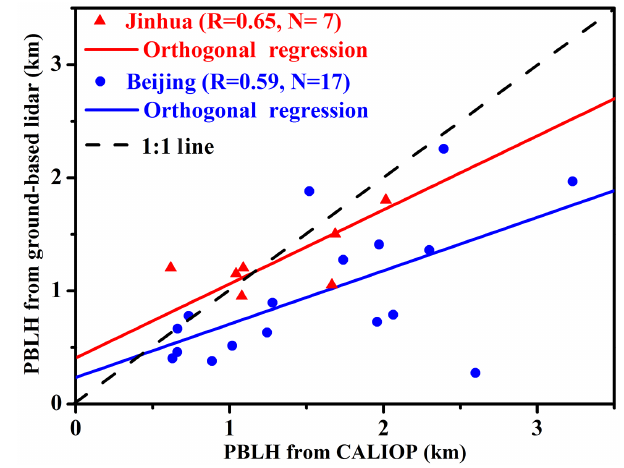
Figure 3. Scatterplot for comparing PBLHs from CALIOP to those from ground-based lidars at Beijing (blue dots) during the period 1 January 2014 to 31 December 2014 and Jinhua (red triangles) during the period of 1 June 2013 to 31 December 2013. Blue and red lines denote the linear fit to the data at Beijing and Jinhua sites, respectively, and the black dashed line the 1 : 1 correlation. The number of collocated data samples and corresponding correlation coefficient ( R ) are shown as